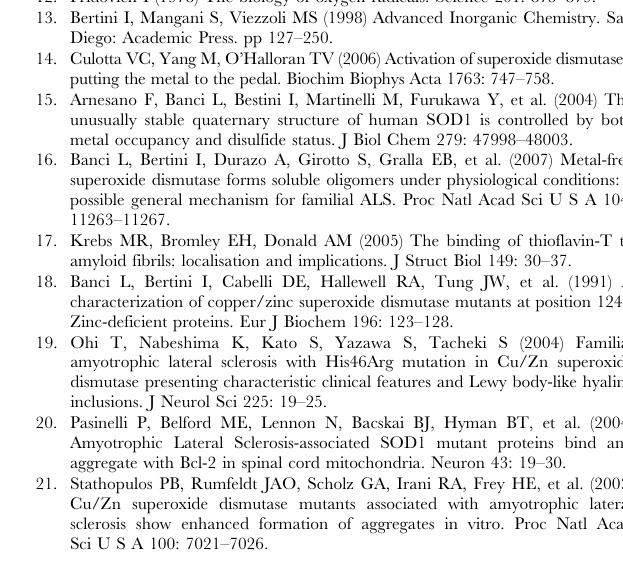
Table S1 Light Scattering analysis. ThT binding fluorescence, as well as species distribution (dimer and aggregate) and average molecular weights of the aggregated species, as detected by light scattering measurements, of apo I113T SOD1 after different periods of incubation.